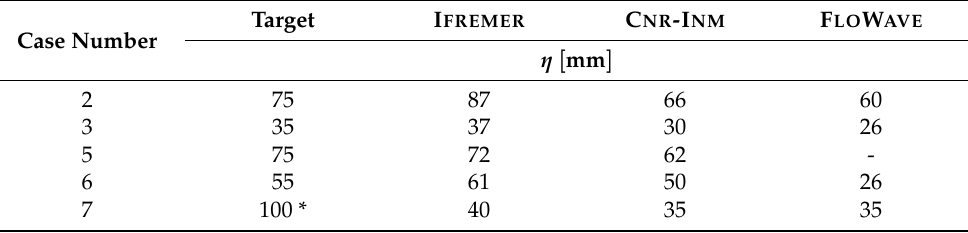
Figure 11. Variation of the average (markers) and standard deviation (shading) of the wave amplitude η with rotational speed for case 2 at all facilities. Dashed lines are the average of the wave amplitude for case 2 at all rotational speed settings per facility. The red line indicates the target wave amplitude of case 2, data obtained with wave probe 3 (see Figure 3). Table 8. Time and case average of the wave amplitude η for all cases at all facilities. Data obtained from wave probe 3 (see Figure 3) in synchronisation with the